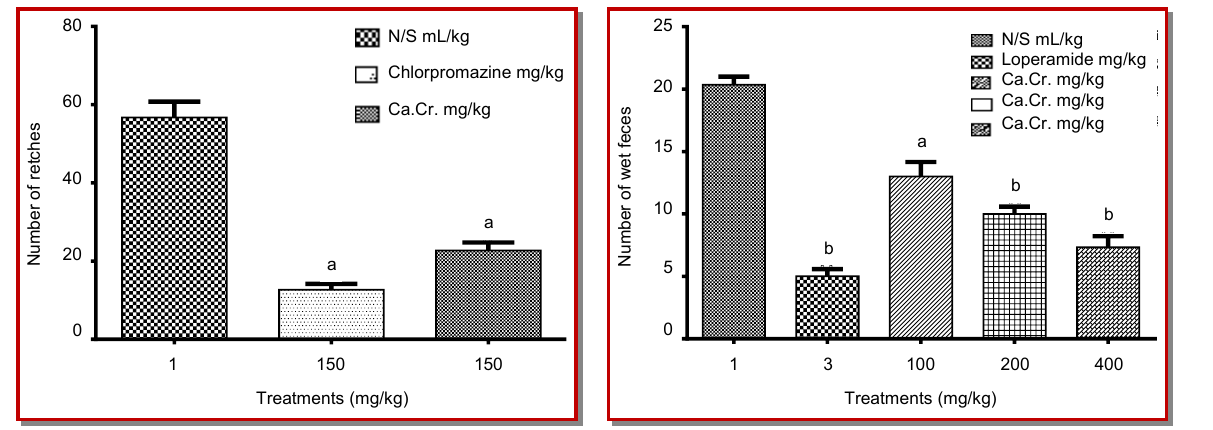
Figure 5: Antidiarrheal effect of different doses of Ca.Cr.(100, 200, 400 mg/kg) using castor oil induced-diarrhoea model in rats, values are expressed as mean ± SEM. Data were analyzed by using unpaired t-test considering p<0.05 as significant. When data were compared with control it showed significant antidiarrheal activity ( a p<0.5, b